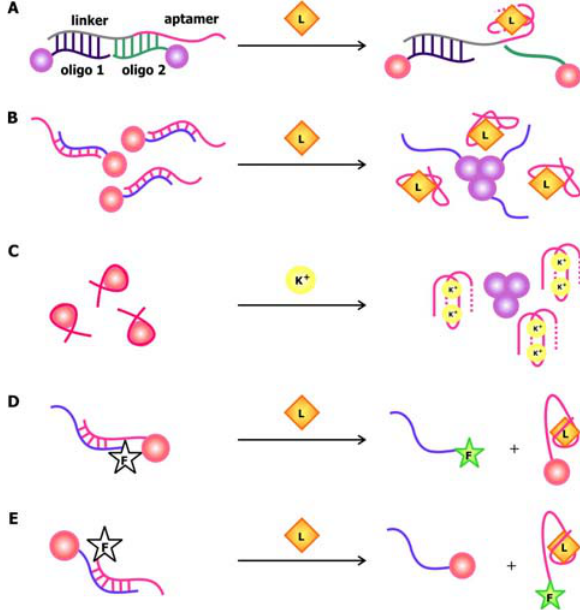
in solution, a red color is observed. However, when the AuNPs aggregate, the color changes the violet. a) AuNP signaling by crosslinking method [50]. b) AuNP signaling by non-crosslinking method [51]. c) Signaling using unmodified AuNPs [52]. d,e)